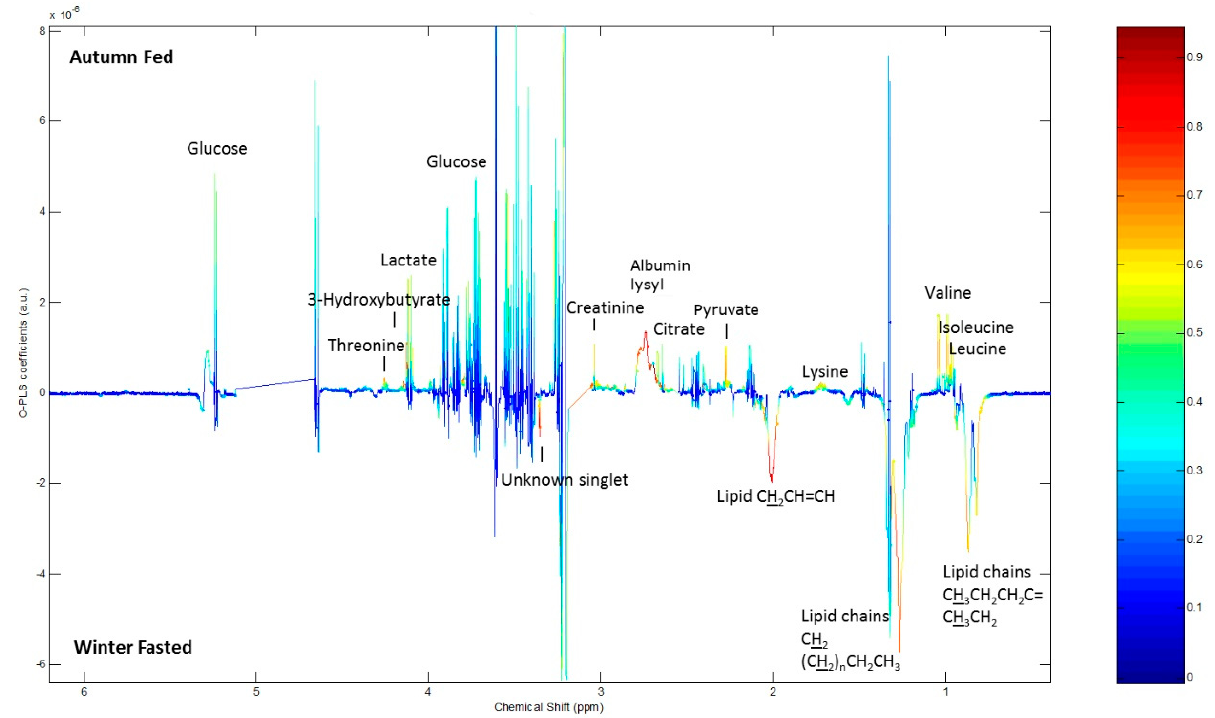
Figure 6. Loadings obtained by an OPLS-DA multivariate analysis on the NMR spectra comparing autumn fed to winter fasted. See Figure 4 caption for